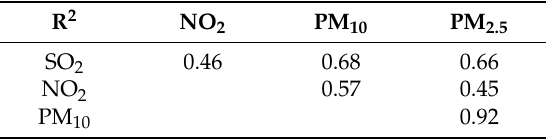
Table 4. Correlation coefficients between daily air pollutant concentrations in Shenzhen in 2013.